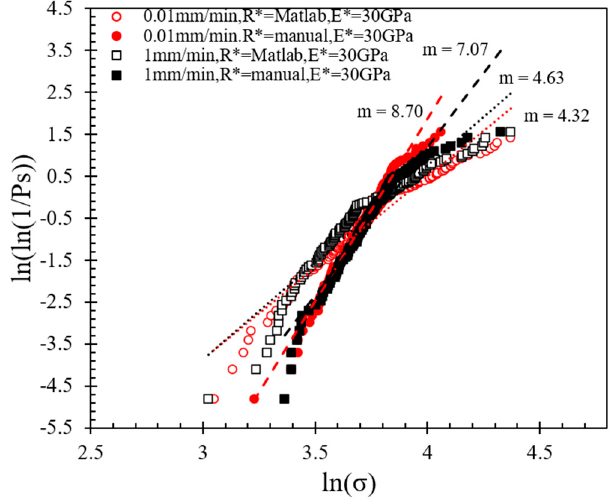
Figure 8. Weibull distribution plots at different loading rates applying Matlab and manual methods